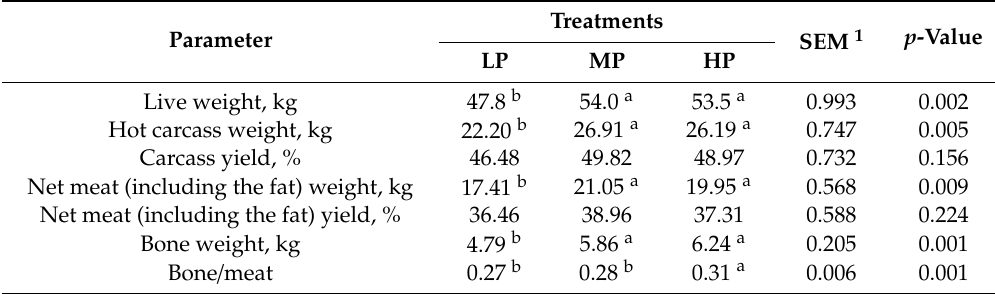
Table 2. E ff ects of three di ff erent dietary protein levels on growth performance in Tibetan sheep (n = 6 per group).